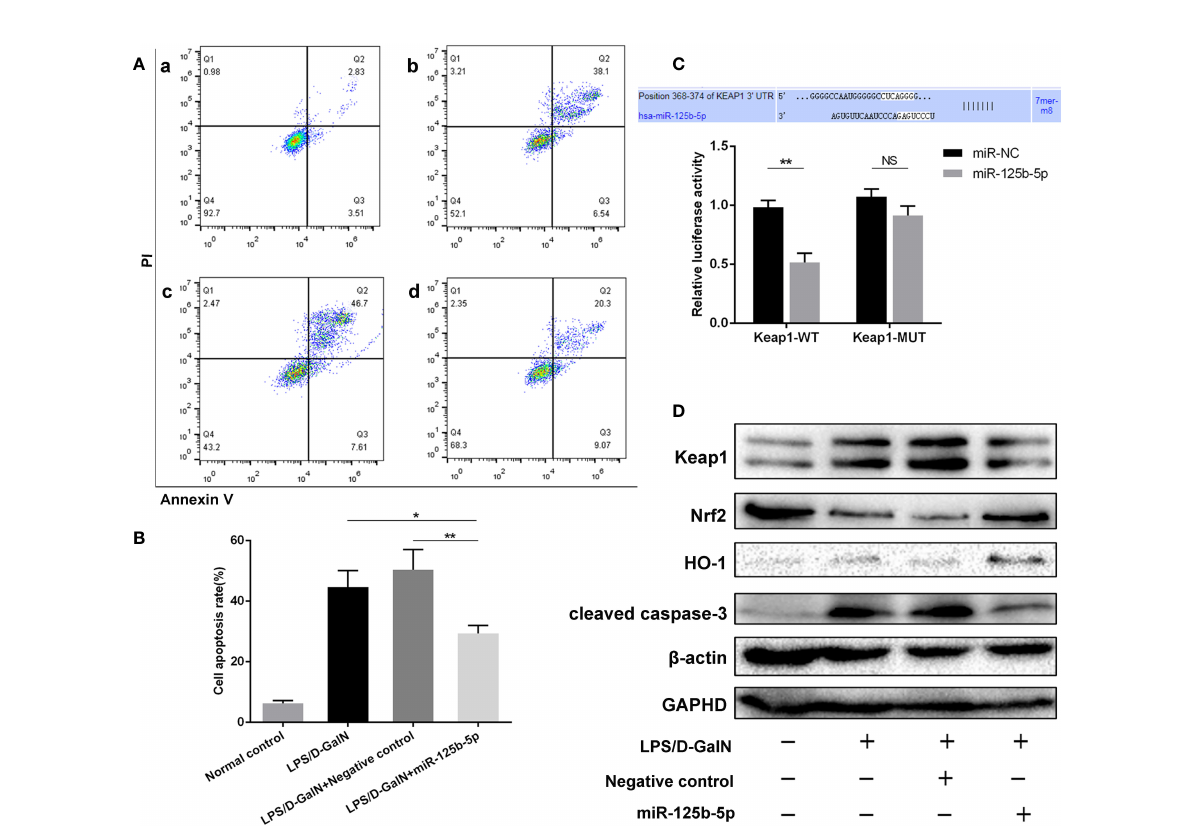
FIGURE 3 Role and mechanism of miR-125b-5p in injured Huh7 cells in vitro . (A) The cell apoptosis rate was calculated by fl ow cytometry. a: Normal control; b: LPS/D-GalN; c: LPS/D-GalN+ Negative control vector; d: LPS/D-GalN+ miR-125b-5p. (B) The cell apoptosis rate was calculated and compared. (C) A luciferase reporter assay was performed to identify the binding sites between human Keap1 and hsa-miR-125b-5p. (D) The expression levels of Keap1, Nrf2, HO-1 and cleaved caspase-3 were evaluated by western blotting. NS, no signi fi cance. * p < 0.05, ** p <